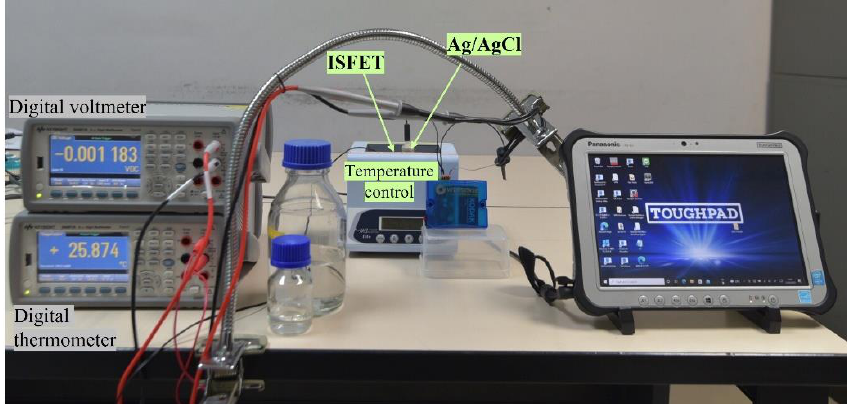
Figure 6. Laboratory experimental setup to collect the ISFET signal and temperature data.